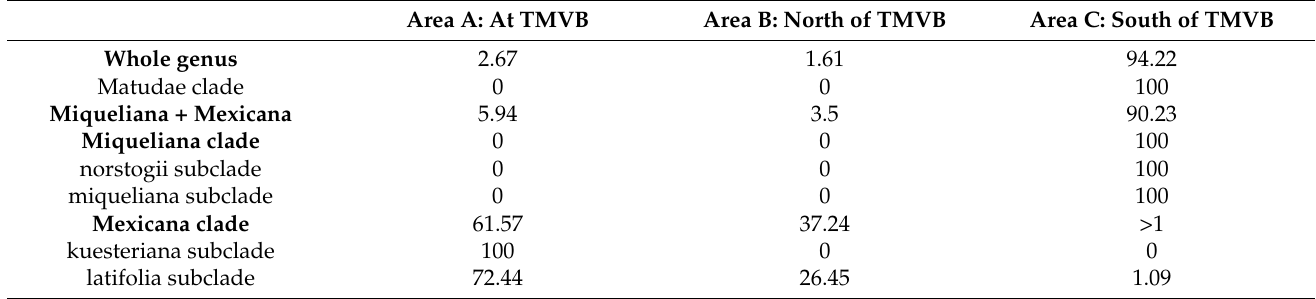
Table 2. Ancestralareaprobability(%age)basedonFigure4foreachofthekeynodesofthegenus Ceratozamia .